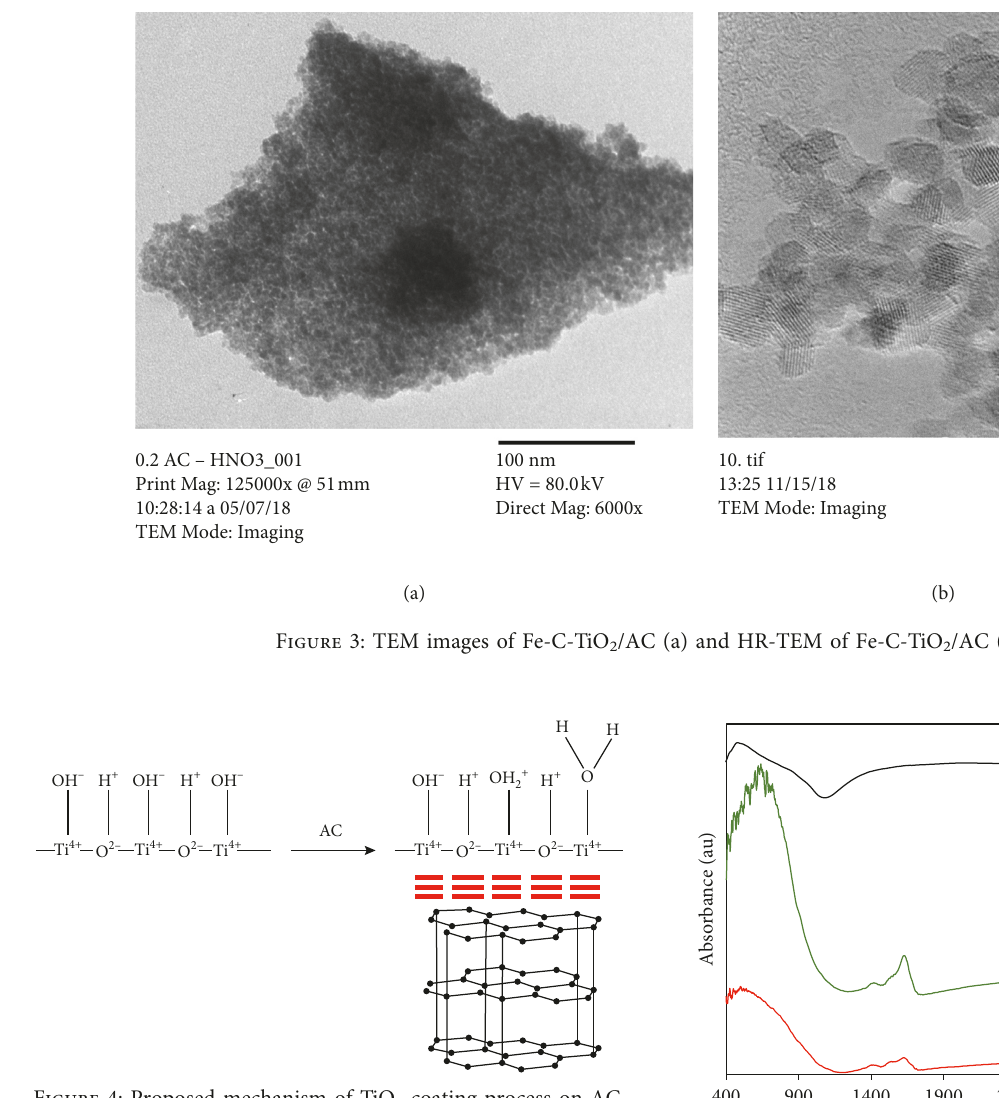
Figure 4: Proposed mechanism of TiO 2 coating process on AC. Table 1: Physical properties of AC, Fe-C-TiO 2 , and Fe-C-TiO 2 /AC. Mean size (nm) from the Materials XRD